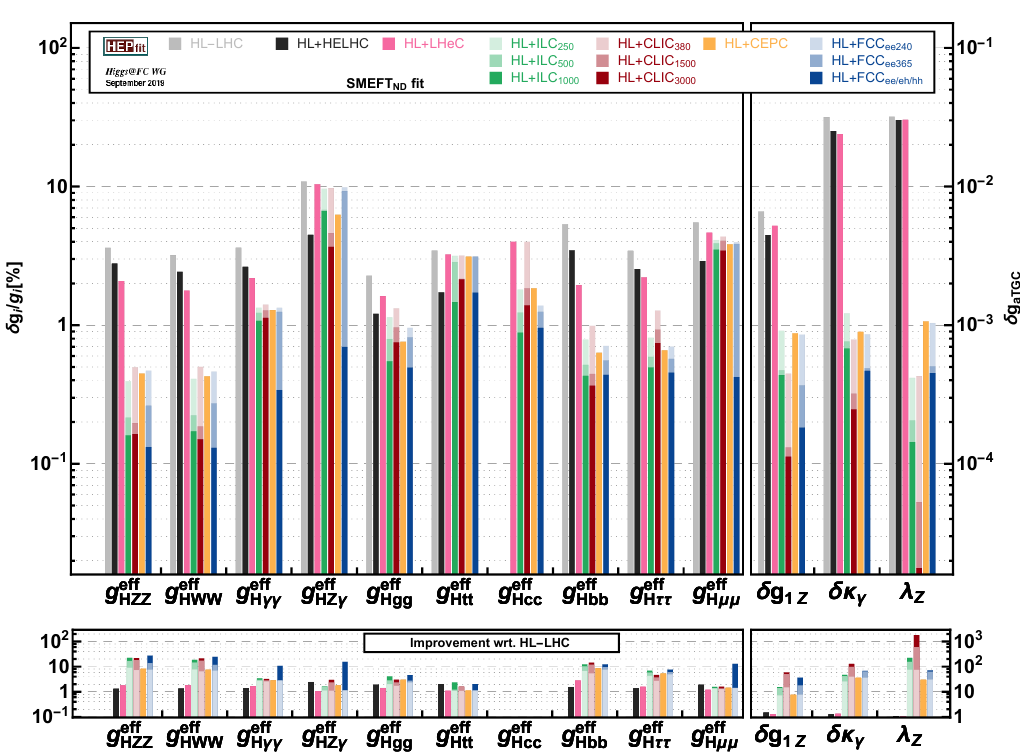
Figure 3 . Sensitivity at 68% probability to deviations in the di(cid:11)erent e(cid:11)ective Higgs couplings and aTGC from a global (cid:12)t to the projections available at each future collider project. Results obtained within the SMEFT framework in the benchmark SMEFT ND . The HE-LHC results correspond to the S 0 assumptions for the theory systematic uncertainties in Higgs processes 2